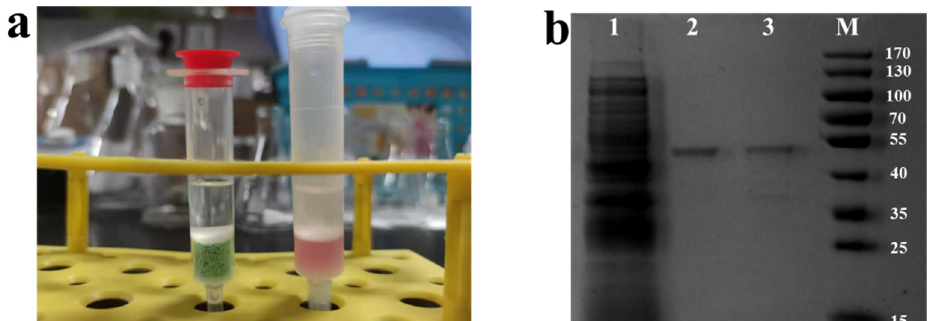
Figure 5. ( a ) Digital photograph of Ni-chelated ion exchange resin column (left) and Co-NTA grav-